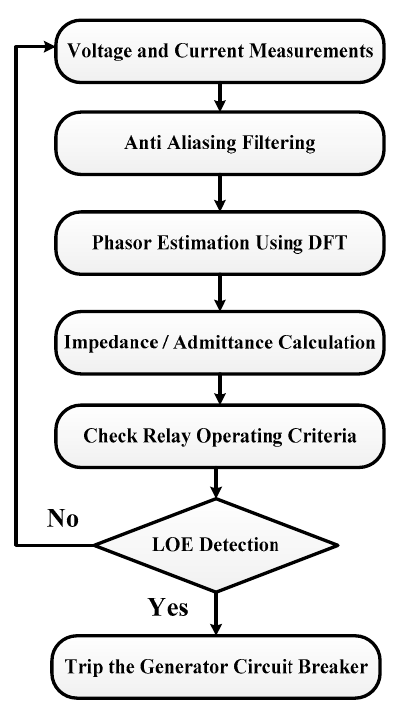
Figure 4. General operating procedure of the traditional LOE relays.